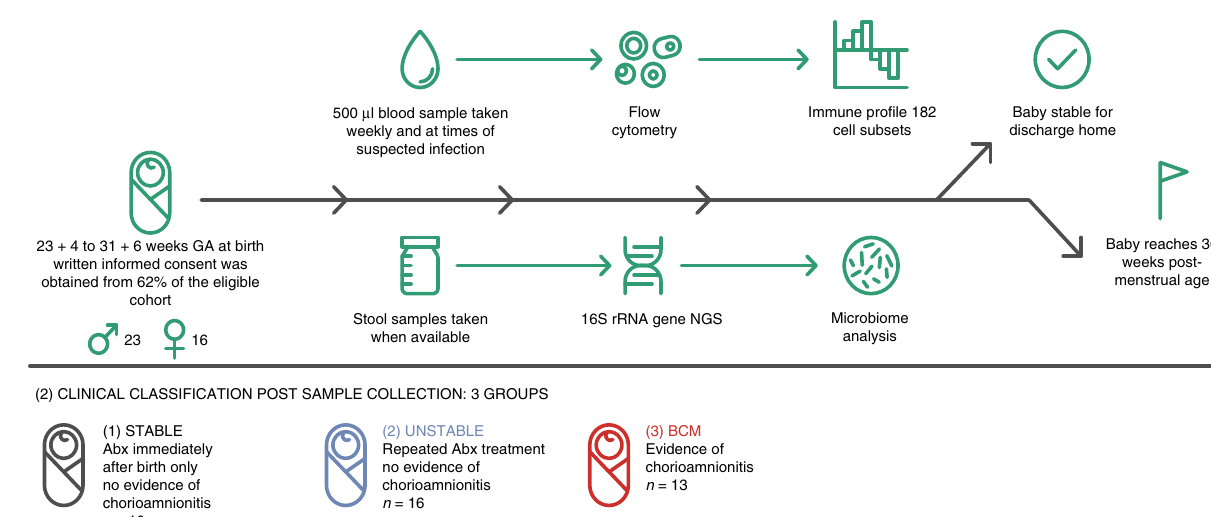
Fig. 1 Schematic representing study design. Written informed consent was obtained from parents before 72 h of age and of the parents approached, 62% agreed to enter the study as described in the fi